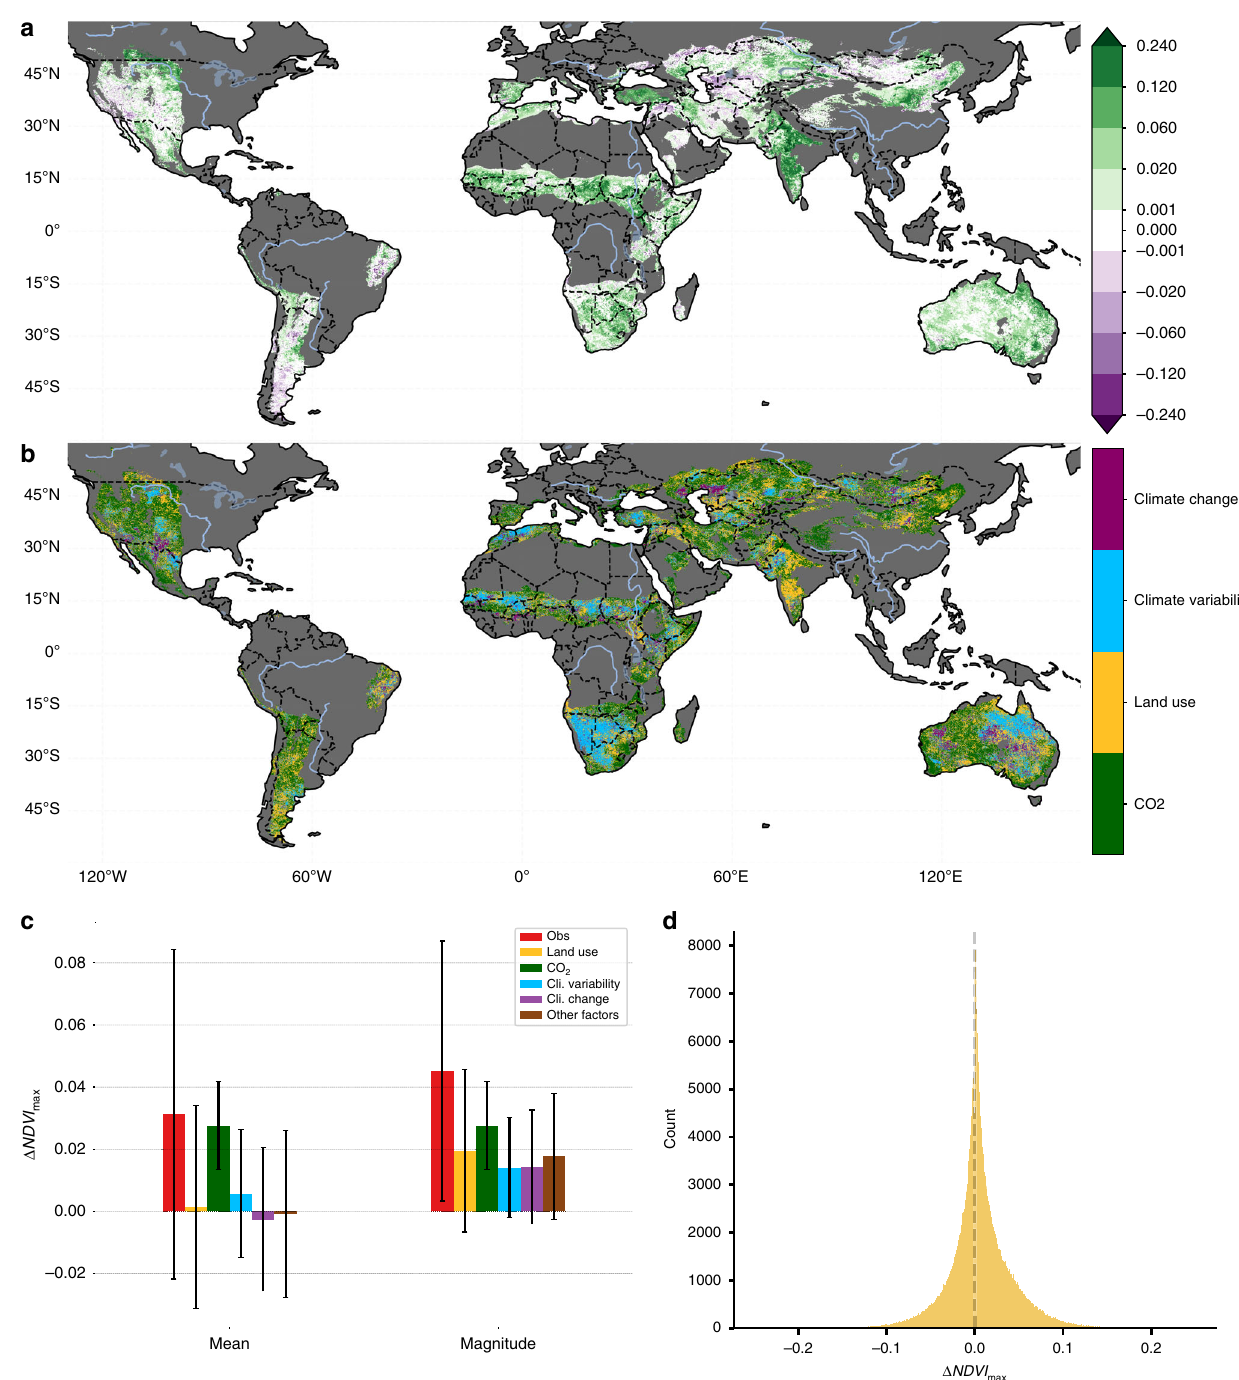
Fig. 1 Primary drivers of vegetation changes between 1982 and 2015. a The observed dryland vegetation change from 1982 to 2015 measured using the change in p Normalized Difference Vegetation Index ( Δ NDVI max ). Non-dryland and hyper-arid regions are masked in dark gray and areas where the change is insigni fi cant ( α FDR = 0.10) or smaller than the error in the sensors (±0.001) are masked in white. b Map showing the largest absolute attributed driver (CO 2 , land use, climate change, and climate variability). Non-dryland regions are masked in dark gray and the magnitude of other factors is not considered. c The mean and magnitude (mean absolute value) of the different drivers of change in NDVI max between 1982 and 2015. The error bars show the SD of the area-weight grid cells. d Frequency distribution function for the change in NDVI max (1982 – 2015) attributed to land use, which shows that there are opposing changes at local scales which cancel out when averaged